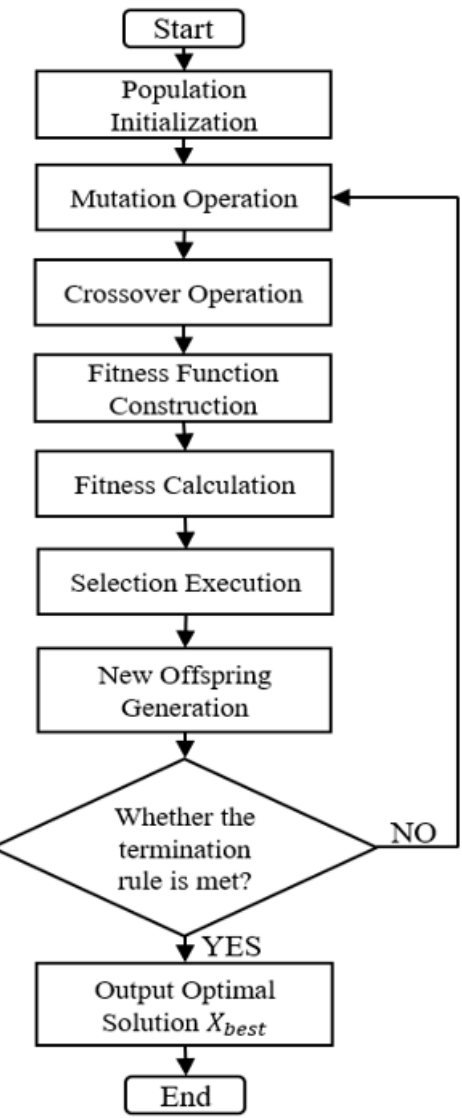
Figure 2. The flow chart of the improved differential evolution algorithm.